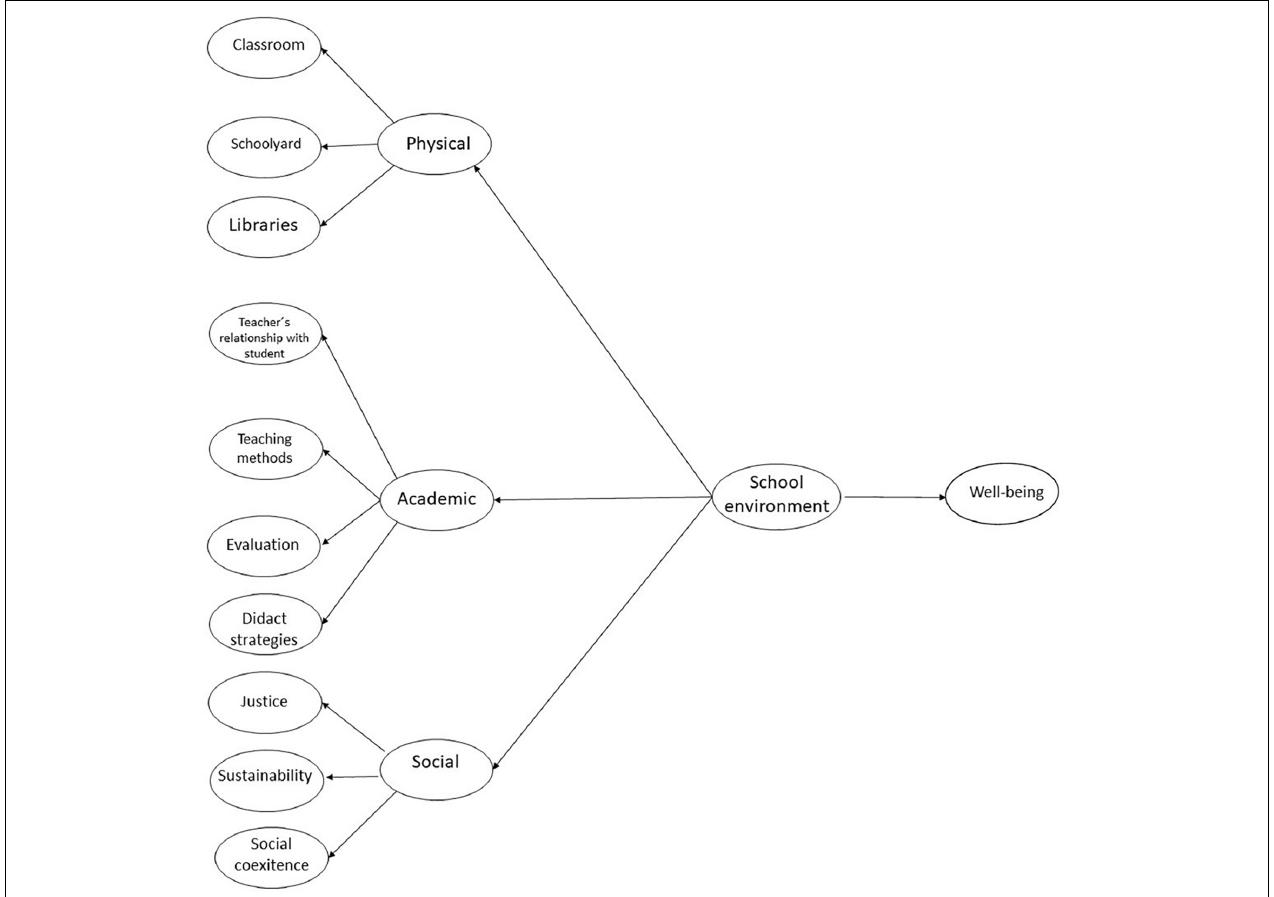
FIGURE 1 | Hypothetic model of the relationship between school environment and